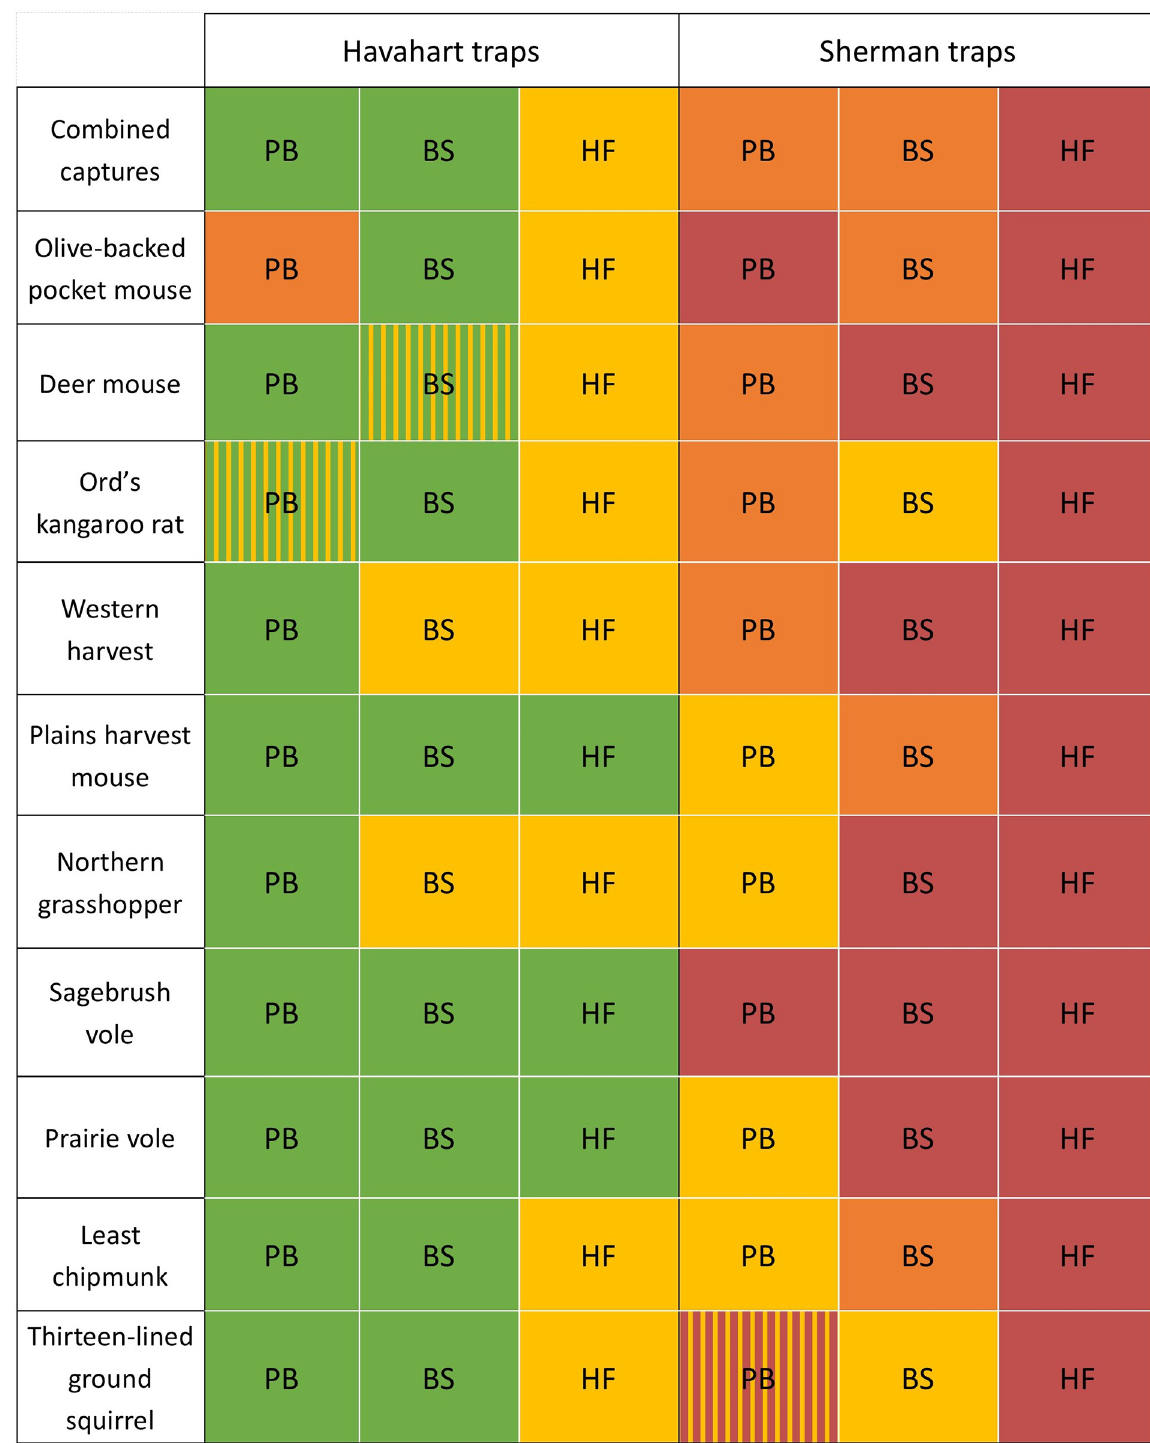
Fig 2. Bait and trap selection by species. Colors represent differences in selection within a species, where trap-bait combinations with the same color are not significantly different from each other. When colors are different, green = strongly positive selection, yellow = weak positive selection, orange = weak avoidance and red = strong avoidance. Bi-color hatching indicates no significant differences from solid colors of the same type. BS = bird seed bait, HF = 3-way horse feed bait, PB = peanut butter bait.